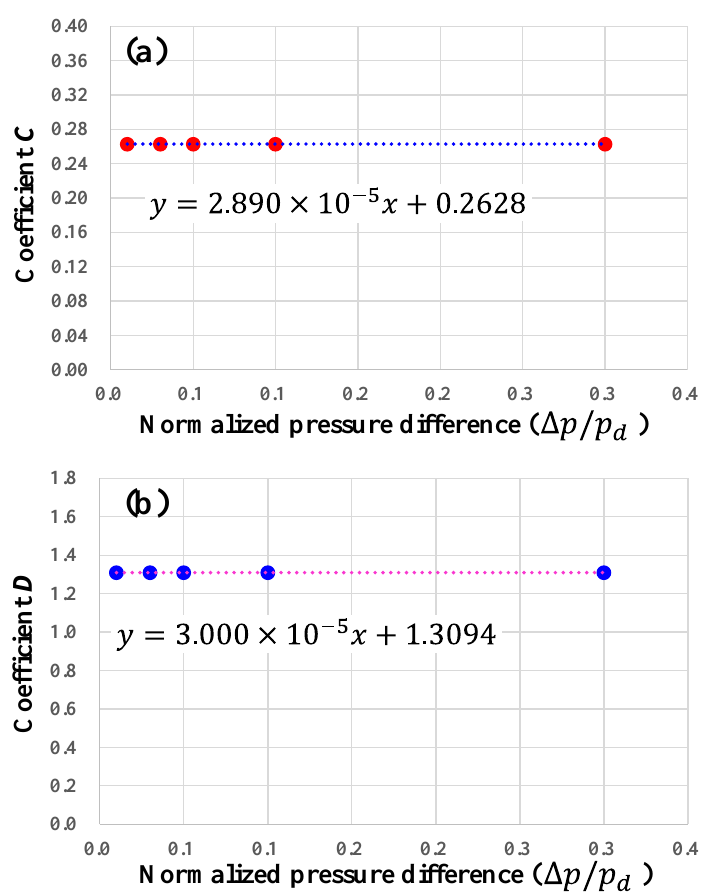
Figure 10. Pressure dependency of coefficients C and D ( R P = 2.2, R V = 3.4 mm).